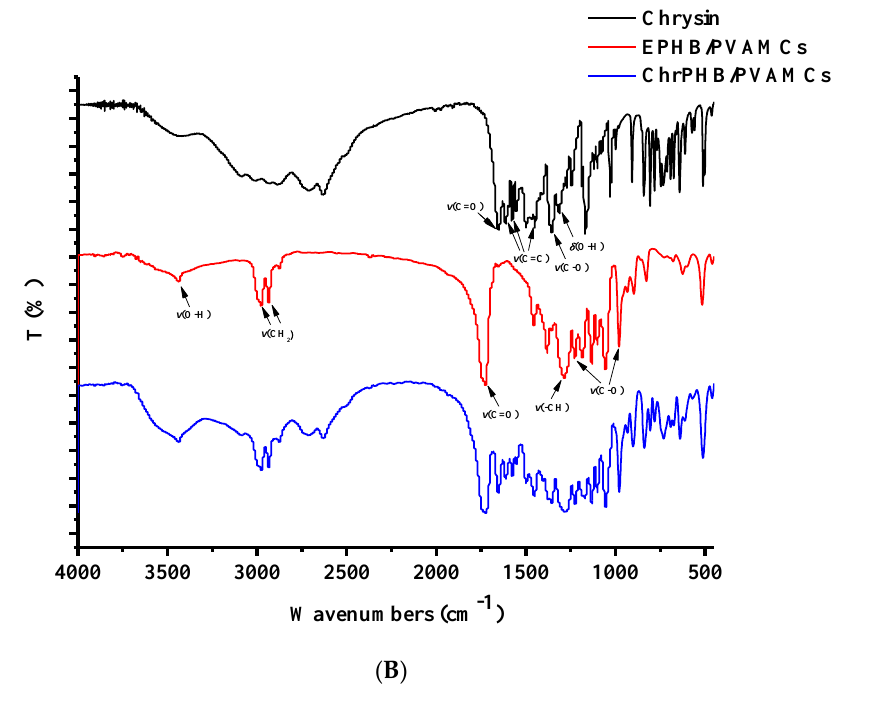
Figure 3. FT-IR spectra of ( A ) chrysin, EPCL/PVAMCs, ChrPCL/PVAMCs, and ( B ) chrysin, EPHB/PVAMCs, ChrPHB/PVAMCs. chrysin, EPHB/PVAMCs,